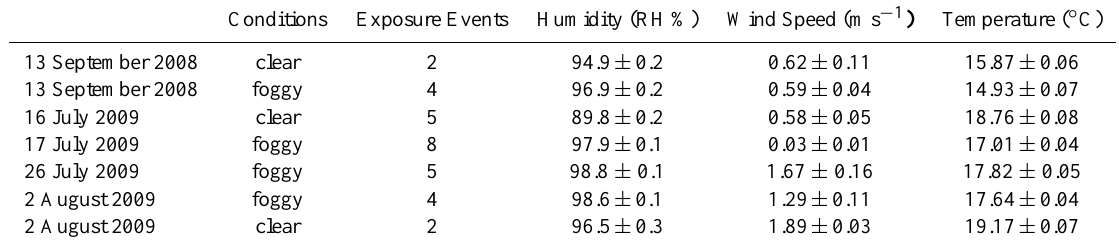
Table 1. Meteorological context during microbial fallout sampling events (under foggy and clear conditions) from coastal Maine, USA.